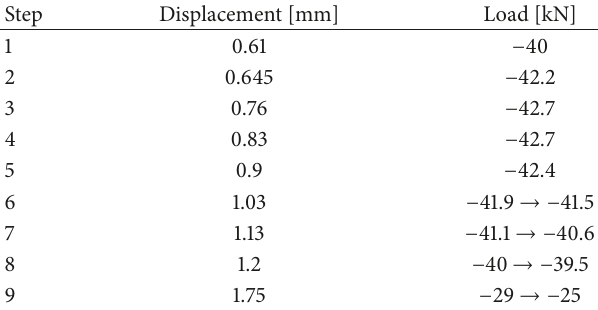
Table 4: Load conditions for the side